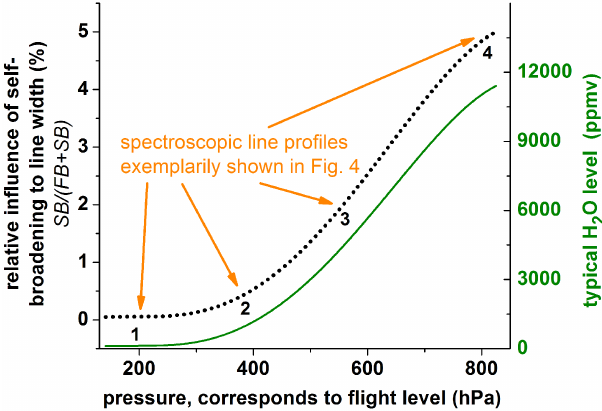
Figure 3. Typical atmospheric vertical water vapour concentration profile (green solid line) vs. total pressure. The total pressure is usu- ally the preferred indicator for flight height. Also shown (black bro- ken line) is the height dependence of the relative contribution (in percent) of self-broadening to the total line width for the water tran- sition used (1370nm). This shows that self-broadening correction is absolutely essential for precise spectroscopic pressure measurement as the self-broadening can contribute up to 5% to the total width. Four selected absorption profiles at different flight levels indicated by numbers 1 to 4 are depicted in Fig.